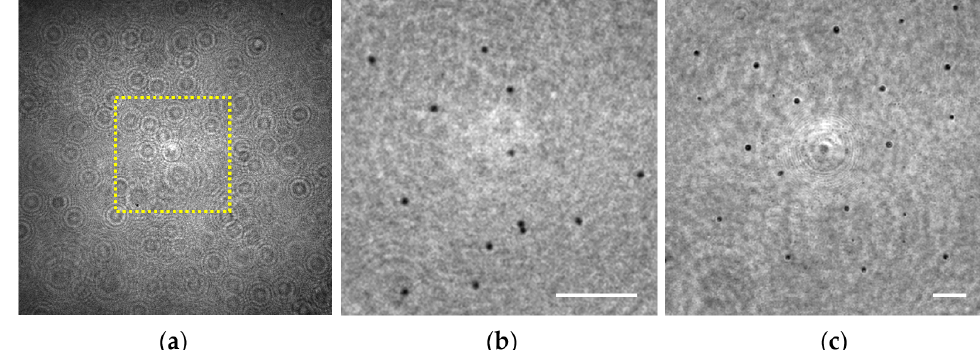
Figure 7. Extended depth of field validation involving 3 μ m spheres distributed in two separated 1 mm planes. ( a ) Digital in-line hologram; ( b , c ) Retrieved intensity images at the sample planes z 1 = 0.7 ± 0.1 mm and z 1 = 1.7 ± 0.1 mm, respectively. Scale bars in ( b , c ) represent 50 μ m.